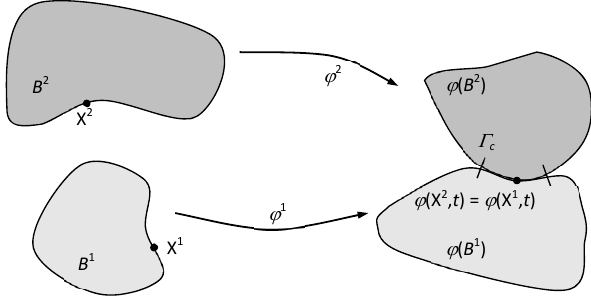
Fig. 1. Finite deformation contact (Wriggers, 2006).